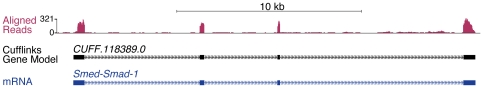
Validation of S. mediterranea transcript assemblies.Transcript assembly for Smed-Smad-1 (CUFF.118389.0). Smed-Smad-1 encodes 4 exons which are supported by RNA-Seq reads (maroon) and an S. mediterranea mRNA sequence.